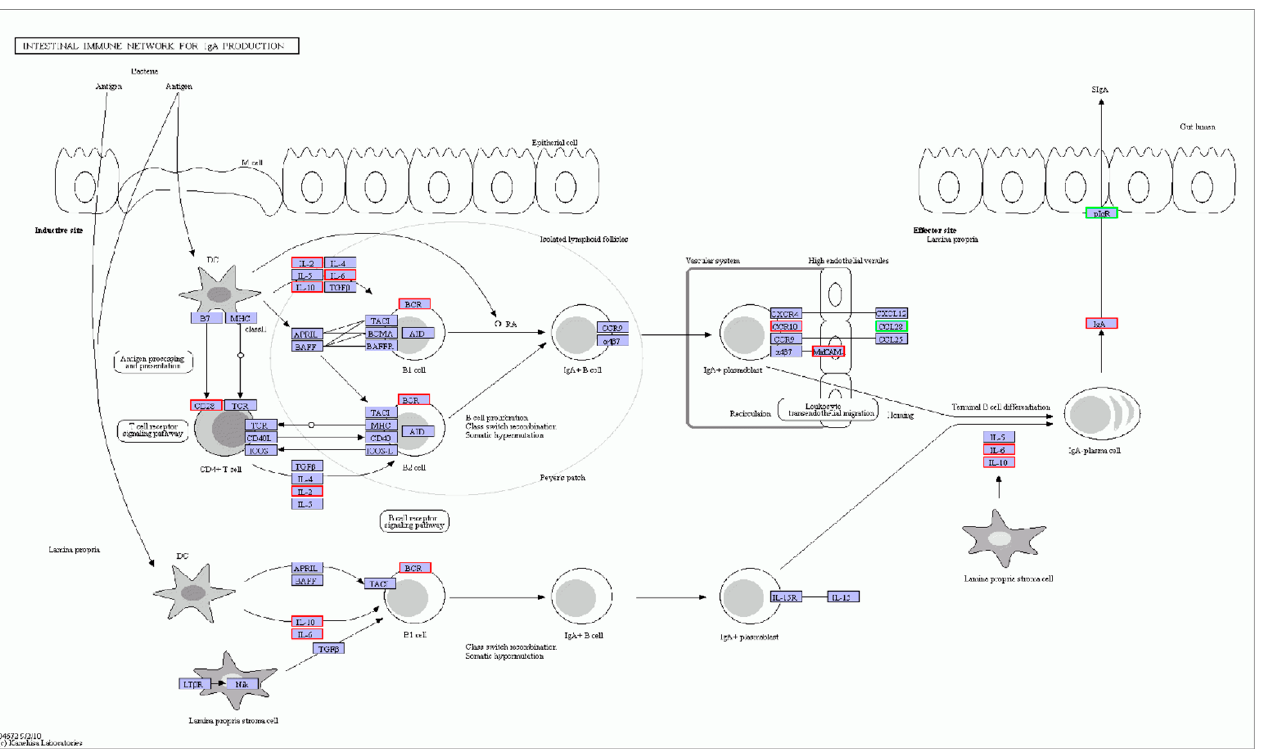
Figure 4. Interaction between signaling pathways and overlapping genes involved in ST infection.